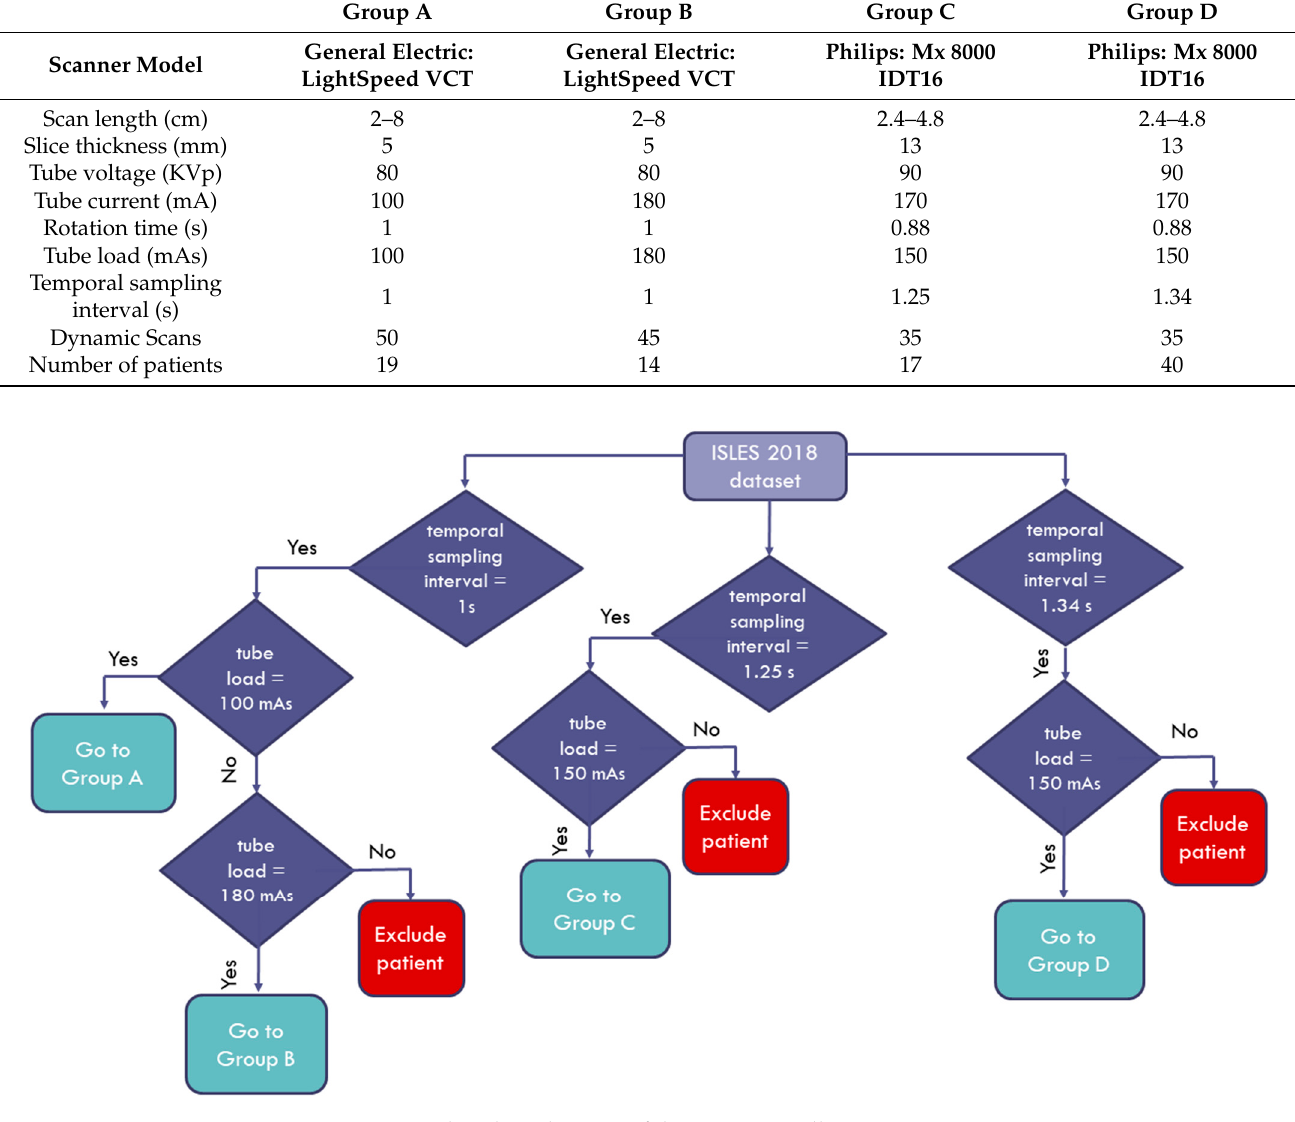
Figure 1. Flowchart diagram of the patient enrollment process. Table 1. Patient groups and imaging parameters for each CT scanner.